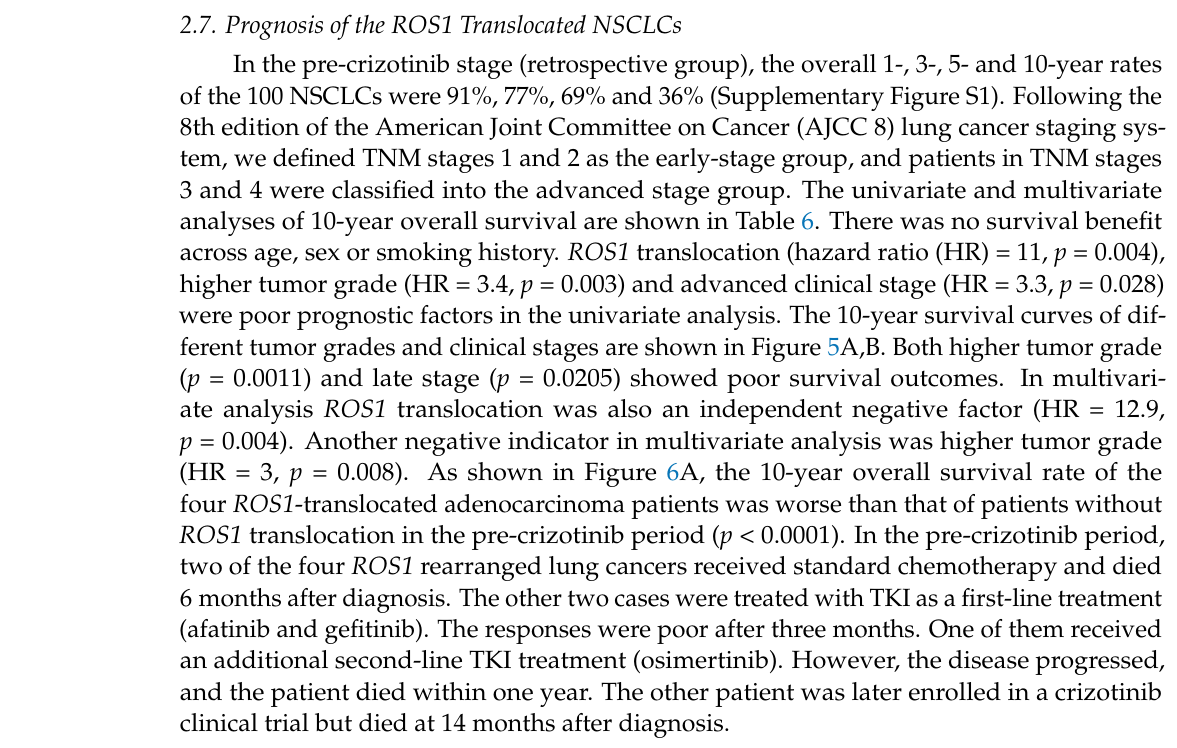
Table 6. Univariate and multivariate analysis for hazard ration in overall